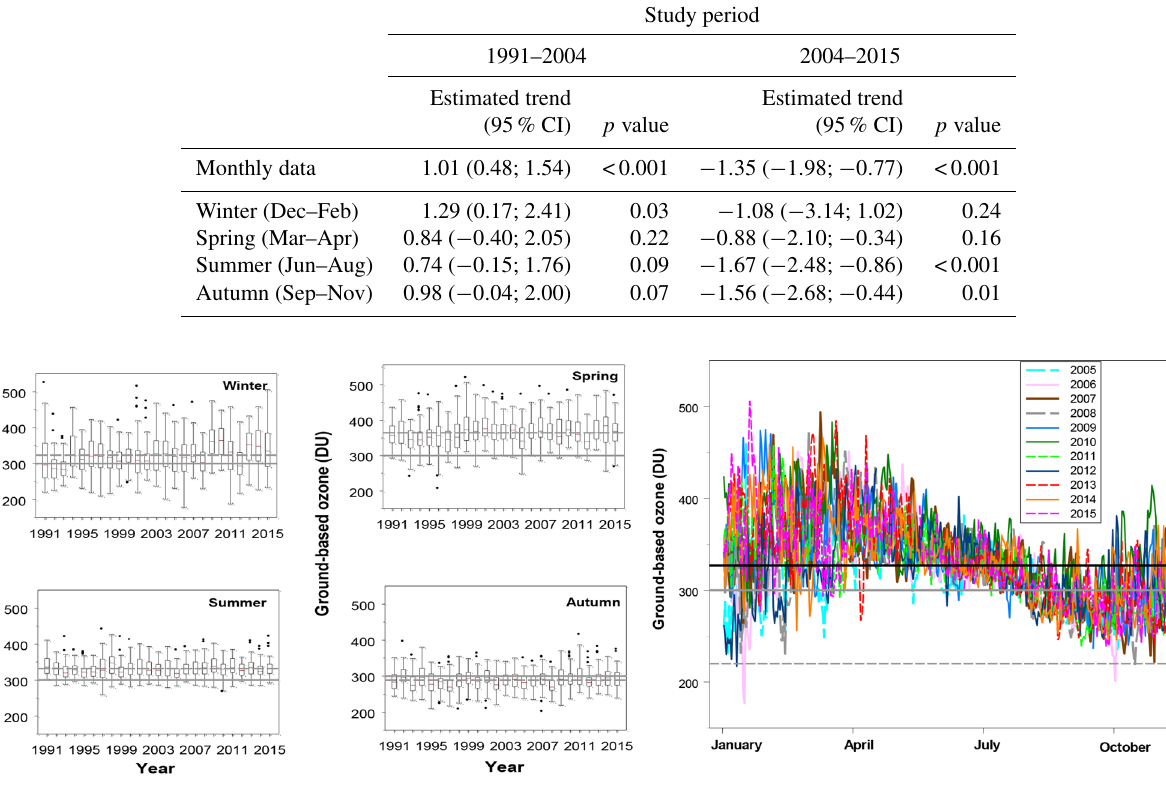
Table 2. Estimated trends (in %yr − 1 ) for H er with 95% confidence intervals (CIs) at Chilton for two sub-periods: 1991–2004 and 2004–